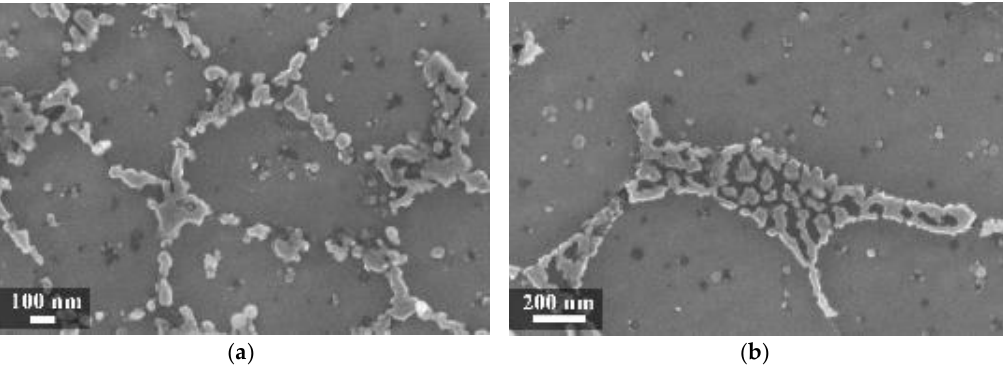
Figure 7. Close-up of the melt pool (MP) zones ( a ) of the silicon-isolated particles in HAZ; ( b ) of the as-built specimens (T platform 35 °C).